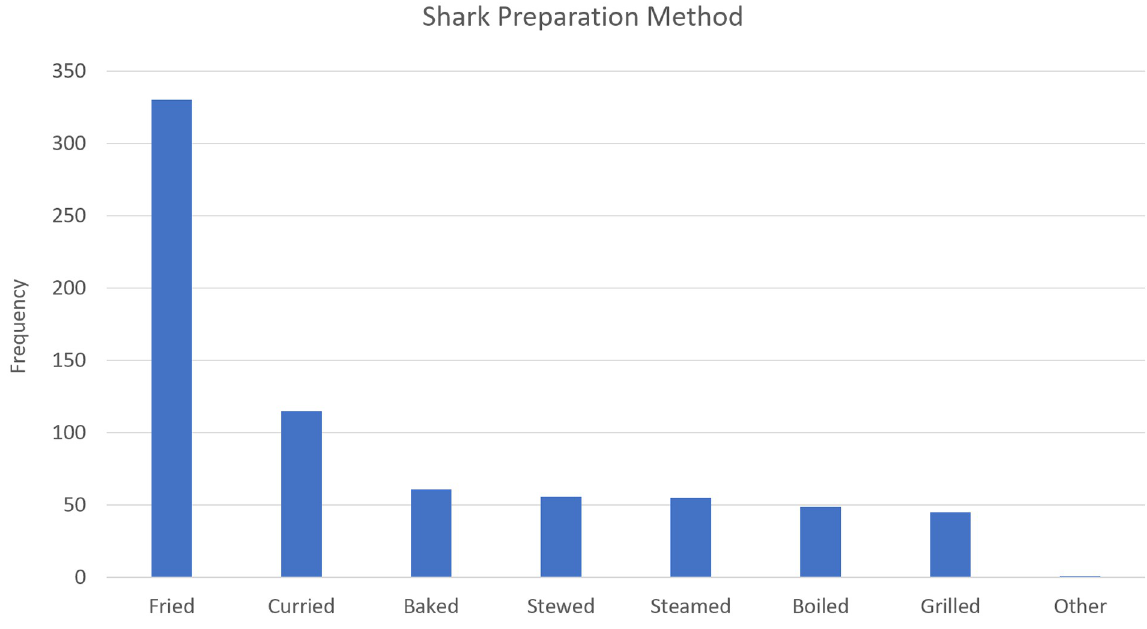
Fig 11. Popularity of methods for cooking shark. (See S3 Appendix for Table).